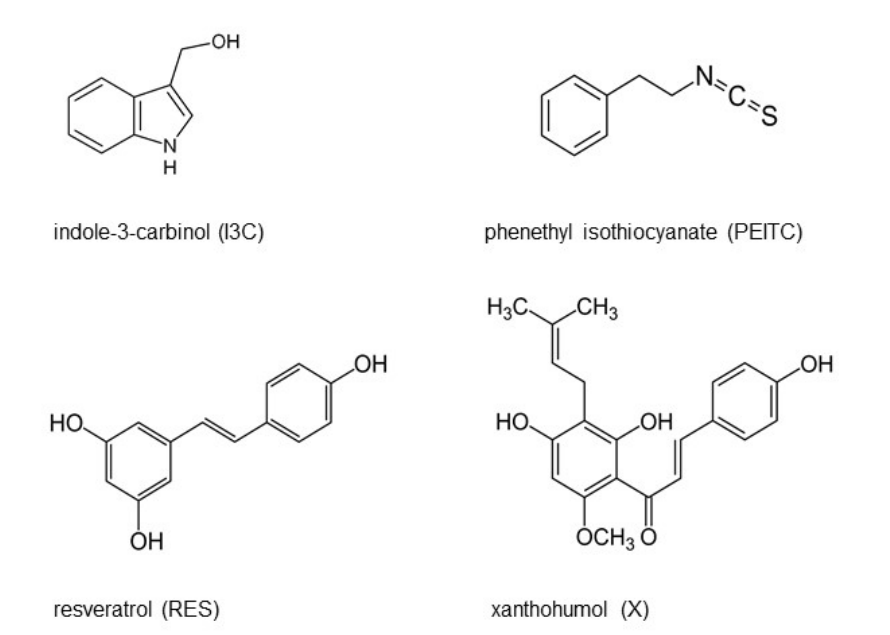
Figure 1. The tested phytochemicals—chemical structures.